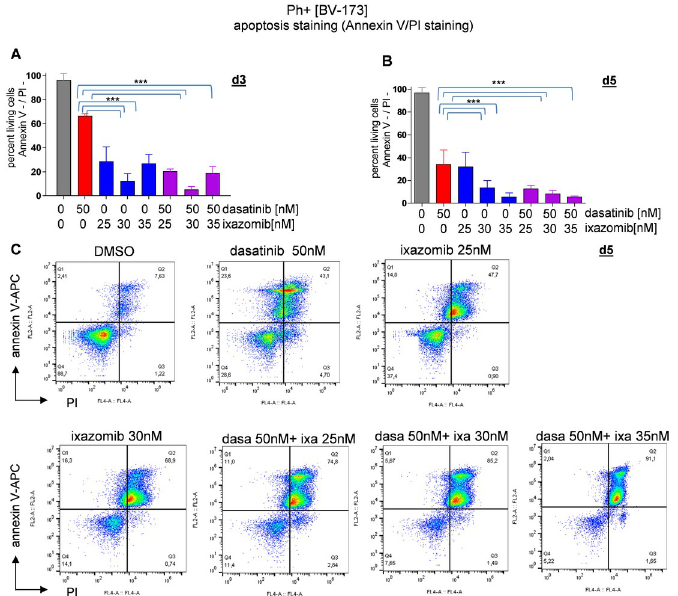
Fig 4. Comparison of apoptotic cell fraction in cells treated with TKI combined with bortezomib or ixazomib, respectively, measured by annexin V / PI staining. Ph+ cells BV-173 were seeded with DMSO and ixazomib at day 0, apoptosis assay was performed at day 3 and day 5. Treatment with ixazomib causes apoptosis in Ph+ ALL cells, detected at day 3 and day 5. (A) At day 3 26.96 ± 7.6% of the cells treated with ixazomib 25nM + dasatinib were non apoptotic (annexin V-/PI-). (B) At day 3 12.56 ± 3.1% of the cells treated with ixazomib 25nM + dasatinib were non apoptotic (annexin V-/PI-). In the graphics only day 5 is shown. (C) 74.8% in late apoptosis at day 5 (annexin V+/PI+)